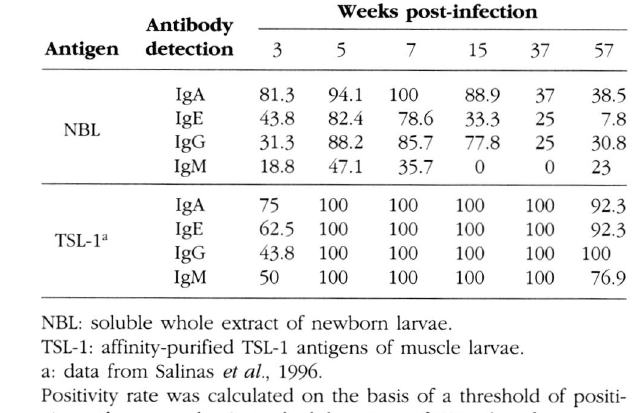
Table I. - Positivity rate of specific isotypes by ELISA assays on serum samples taken from trichinellosis patients during one year of infec­